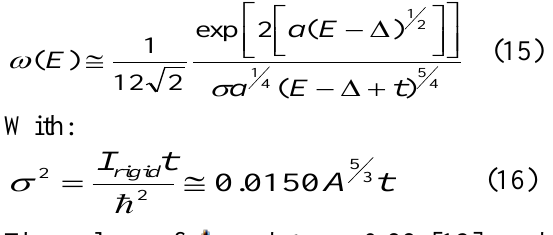
Fig.2: The level density parameter as a function of the mass number for even-even, odd-odd and odd mass nuclei taken from the experimental results of ref.[10] compared with the energy dependent level density parameter with MeV, the energy independent level density parameter and the BSFG ED level density parameter calculated in this work and taken from Table